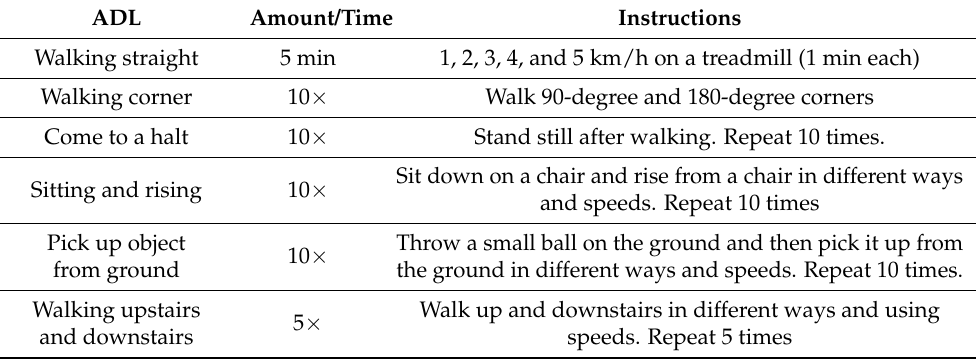
Table 1. Activities of Daily